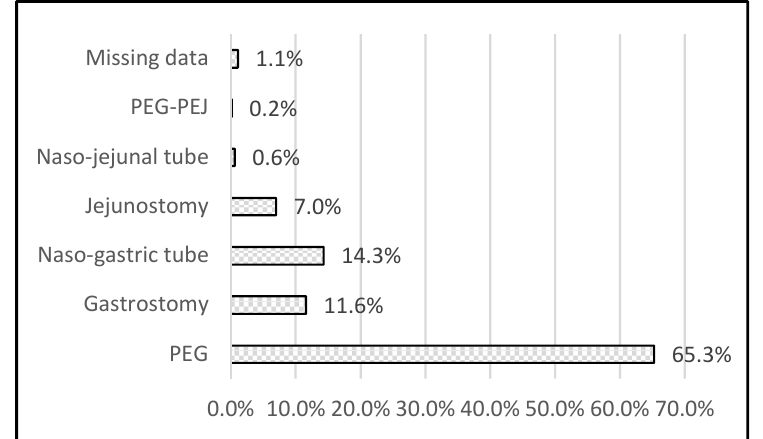
Figure 1. Access route for enteral nutrition. PEG—Percutaneous endoscopic gastrostomy, PEG–PEJ— Percutaneous endoscopic gastrostomy/jejunostomy. Table 3. Administration technique and energy provision.